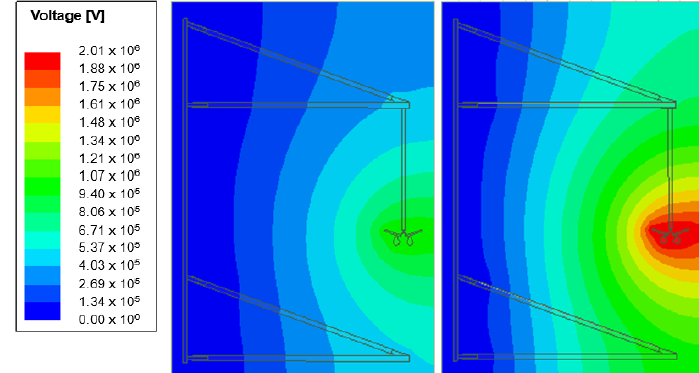
Table 4. Maximum electric field under BIL voltage.